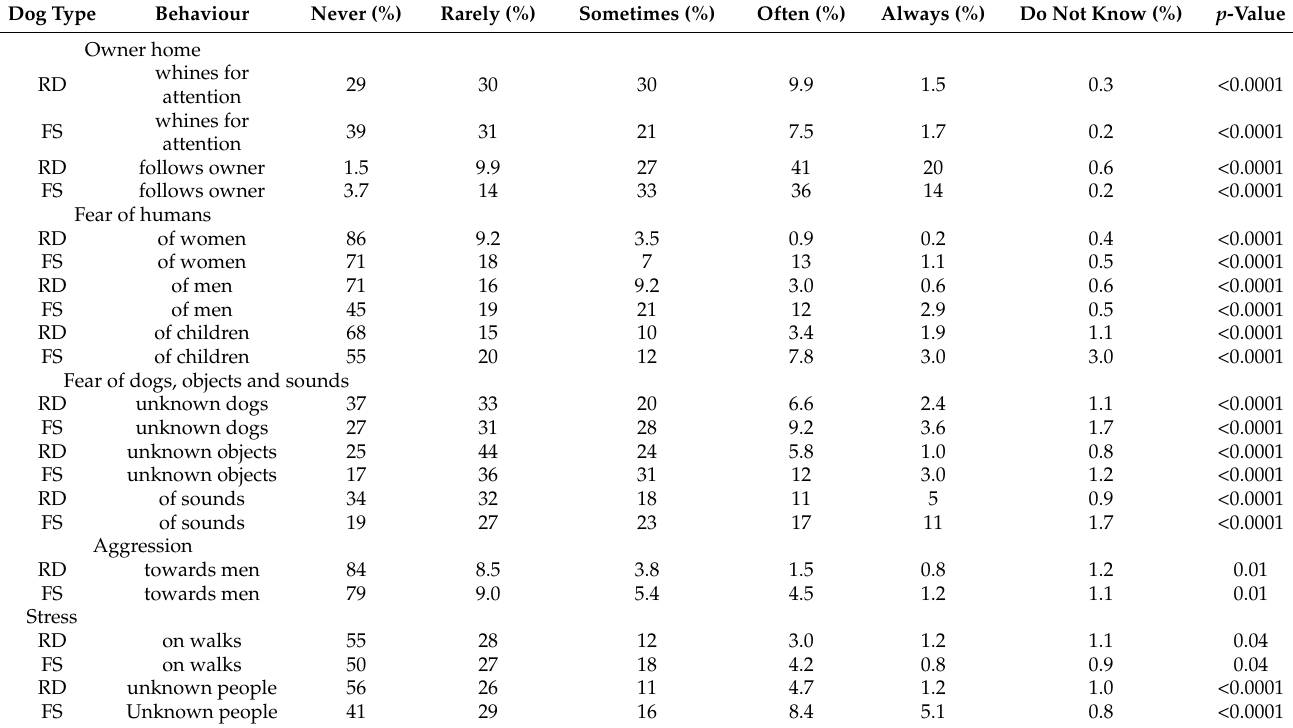
Table 2. Distributions of responses and results from univariable Mann–Whitney U tests, with p -values for 11 questions with significantly different responses and the distribution of answers to questions about behaviours from owners of former street (FS) dogs and dogs reared in Denmark (RD), with six response